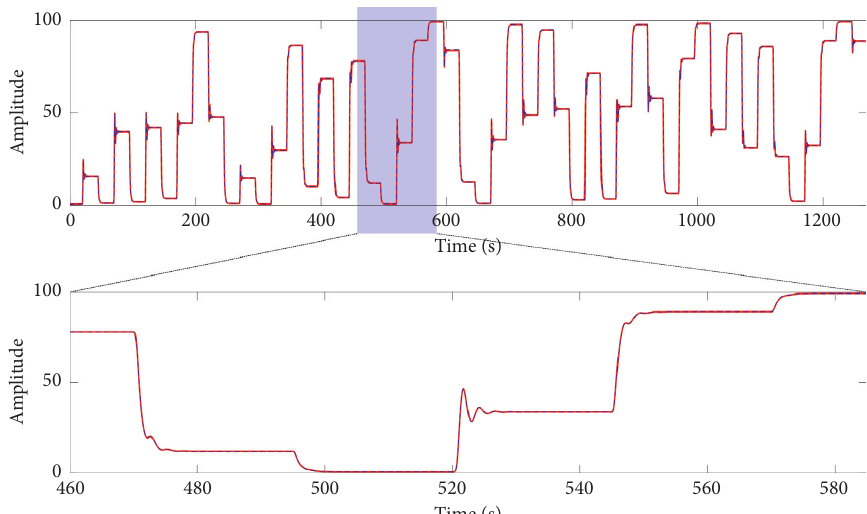
Figure 17: Validation results for numerical example 3: real output (red) and model output (blue dashed line).